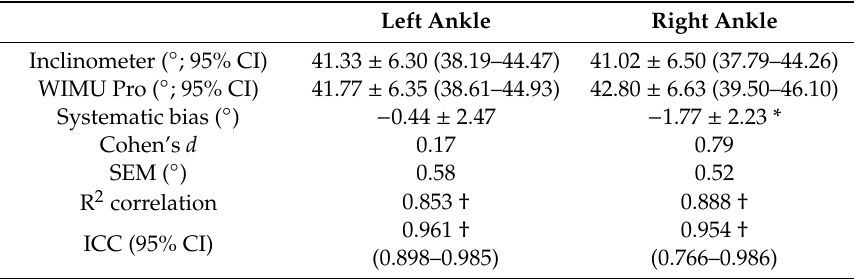
Table 1. Concurrent validity analysis for measuring ankle dorsiflexion.